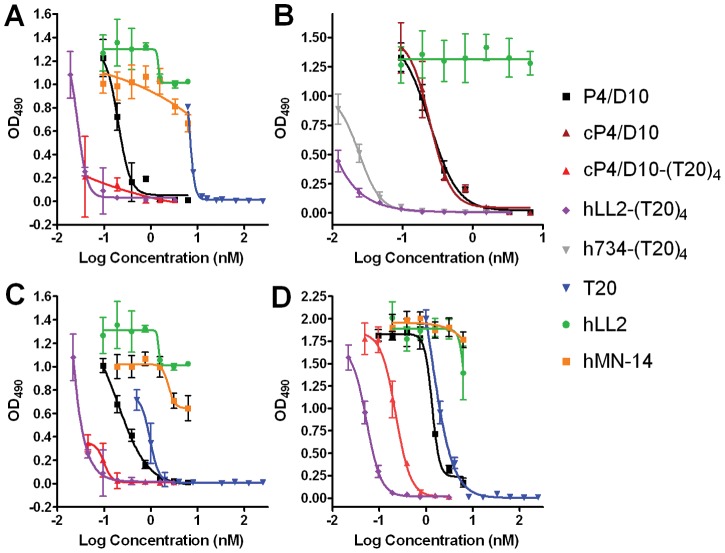
Comparing the potency of P4/D10, cP4/D10, h734-(T20)4, and hLL2-(T20)4 for neutralization of HIV-1IIIB in Jurkat T cells dosed at 50 TCID50 (A) and 100 TCID50 (B), and HIV-16794 in PBMCs dosed at 50 TCID50 (C) and 100 TCID50 (D).